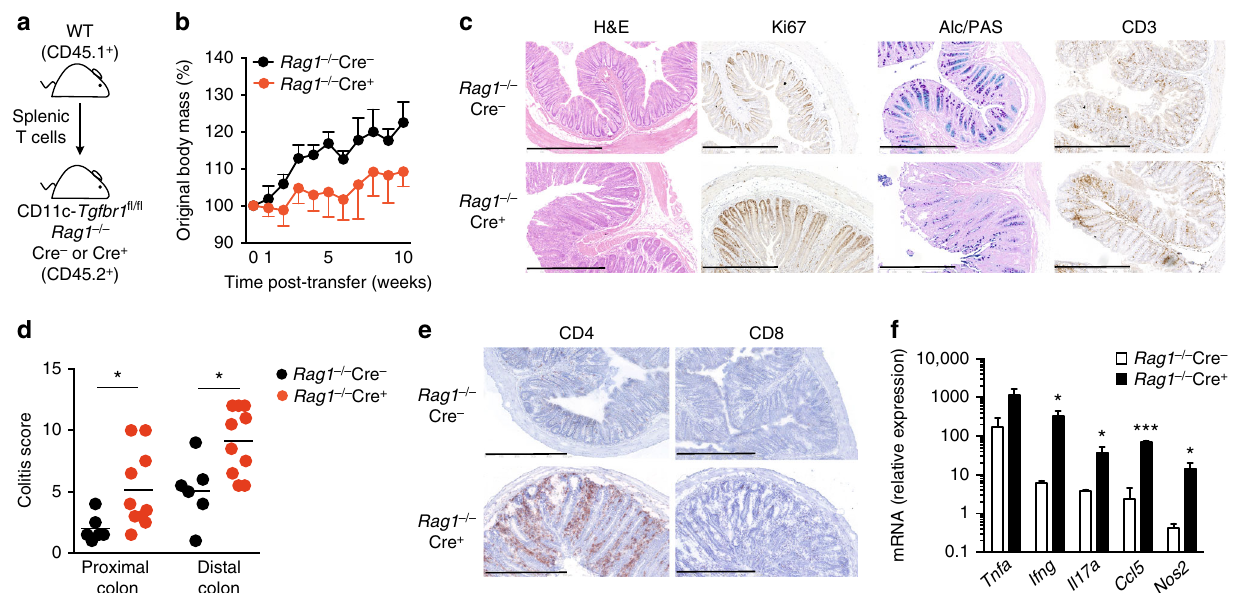
Fig. 2 TGF β R1 signalling in CD11c + myeloid cells prevents T-cell-mediated colitis. a Experimental scheme for induction of colitis by transfer of CD45.1 + WT spleen T cells mice into Rag1 − / − Tgfbr1 fl / fl ( Rag1 − / − Cre − ) or Rag1 − / − CD11c - Cre. Tgfbr1 fl / fl ( Rag1 − / − Cre + ) recipients. b Body weights following adoptive transfer of WT T cells shown as percentage of starting weight. The results are the means ± 1 SD of four mice per group from one of two independent experiments. c Representative colonic pathology as assessed by haematoxylin and eosin staining, Ki67 staining of dividing epithelial cells, PAS + goblet cells and CD3 + T cells at 10 – 17 weeks post-transfer. Scale bar , 500 μ m. d Histological scoring of proximal and distal colon. Data are pooled from four independent experiments with a total of six ( Rag1 − / − Cre − ) or nine ( Rag1 − / − Cre + ) recipients per group. * p < 0.05 determined by Mann – Whitney test. e CD4 and CD8 expression in colon at 10 – 17 weeks post transfer. Scale bar , 500 μ m. f Expression of mRNA transcripts for Tnfa , Ifng , Il17a , Ccl5 and Nos2 in the colon. Error bars represent the mean + 1 SD of two ( Rag1 − / − Cre − ) or fi ve ( Rag1 − / − Cre + ) mice per group and mRNA expression is relative to expression of Abl . Data are from one of three independent experiments performed. * p < 0.05 and *** p < 0.001 determined by two-tailed Student ’ s t